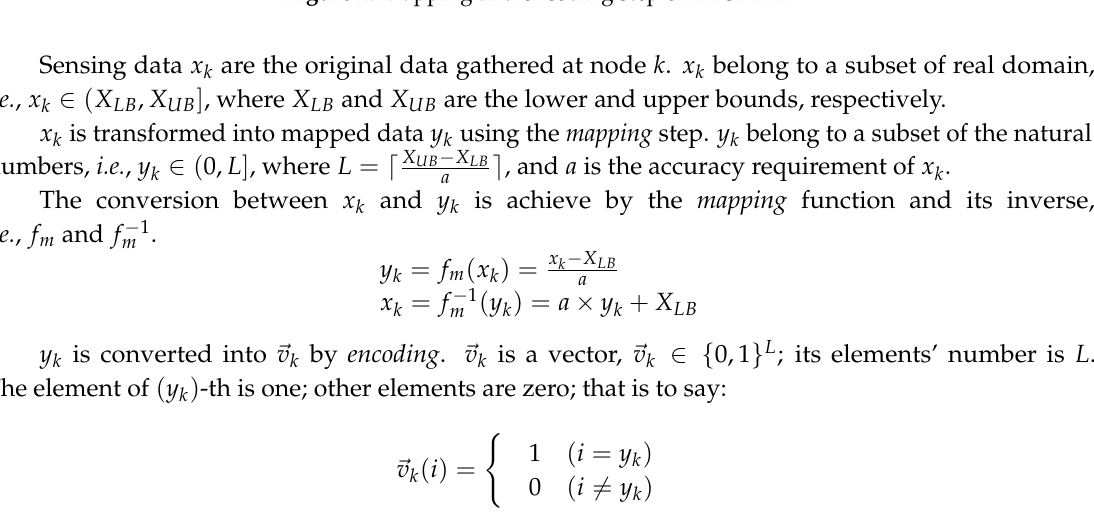
Figure 2. Mapping and encoding step of